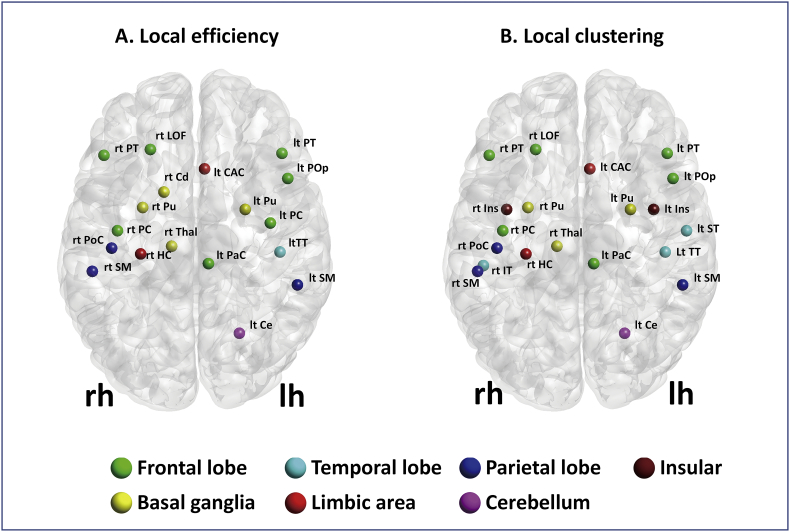
Local metrics results.(A) Regions with decreased local efficiency in patients with PD, as compared to healthy controls (P < 0.025, FDR corrected). (B) Regions with decreased local clustering in patients with PD as compared to healthy controls (P < 0.025, FDR corrected). Probabilistic MSMT-CSD was the only algorithm that detected significant between-group differences in local topological measures. Local efficiency and clustering were reduced in patients with PD in several regions, including the motor area, frontal temporoparietal associative area, limbic area, basal ganglia, and thalamus. Abbreviations: lh, left hemisphere; rh, right hemisphere; CAC, caudal anterior cingulate gyrus; Cd, caudate; Ce, cerebellum; FDR, false discovery rate; HC, hippocampus; LOF, lateral orbitofrontal; MSMT-CSD, multi-tissue constrained spherical deconvolution; PaC, paracentral gyrus; PC, precentral gyrus; PD, Parkinson's disease; PoC, postcentral gyrus; PoP, pars opercularis; PT, pars triangularis; Pu, putamen; SM, supramarginal gyrus; Thal, thalamus; TT, transverse temporal gyrus.